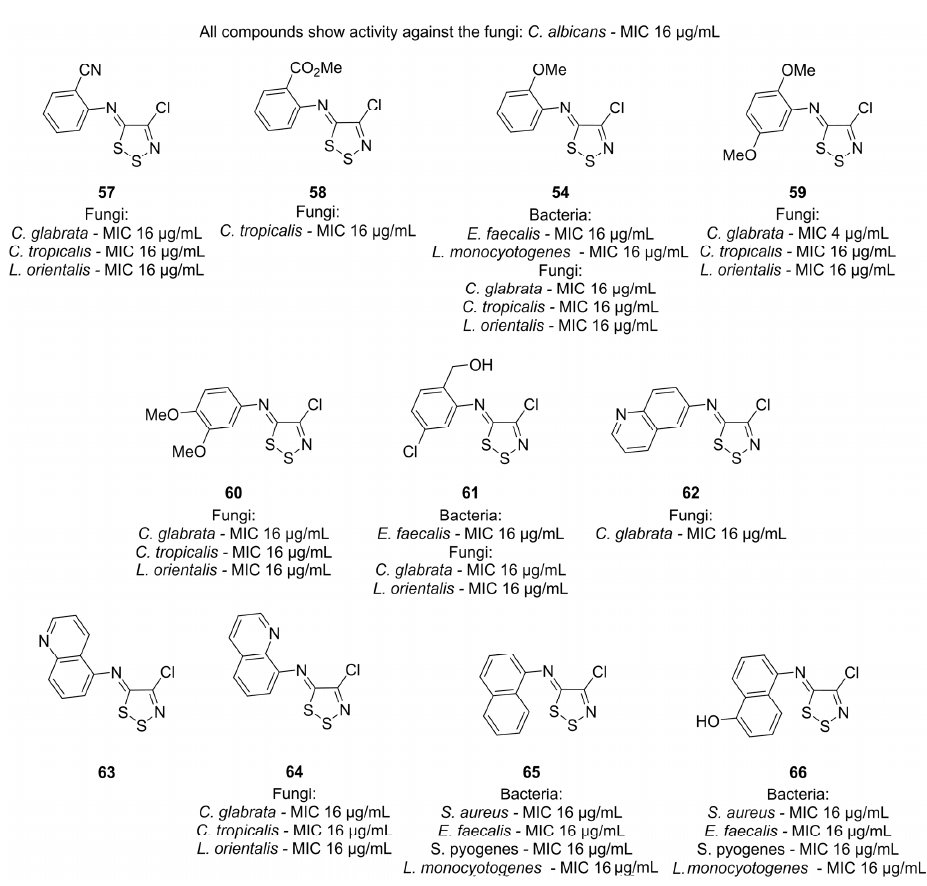
Figure 10. Results of a focused investigation of antibacterial and antifungal activities of selected 1,2,3-dithiazoles